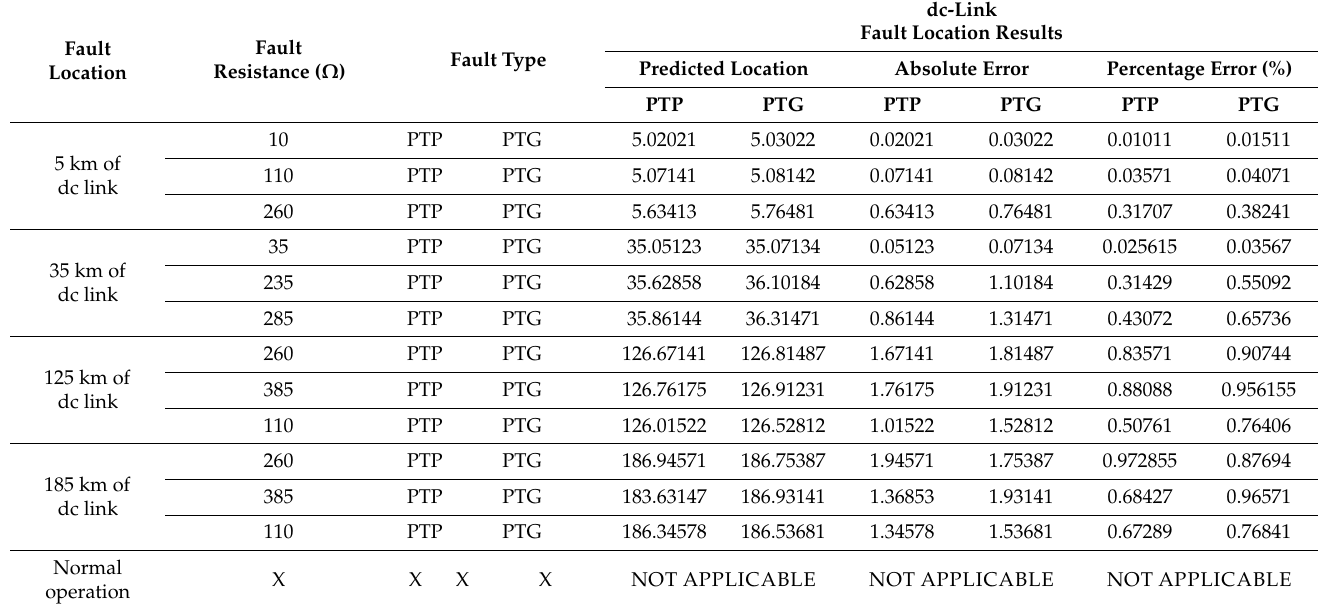
Table 9. Fault resistance estimation